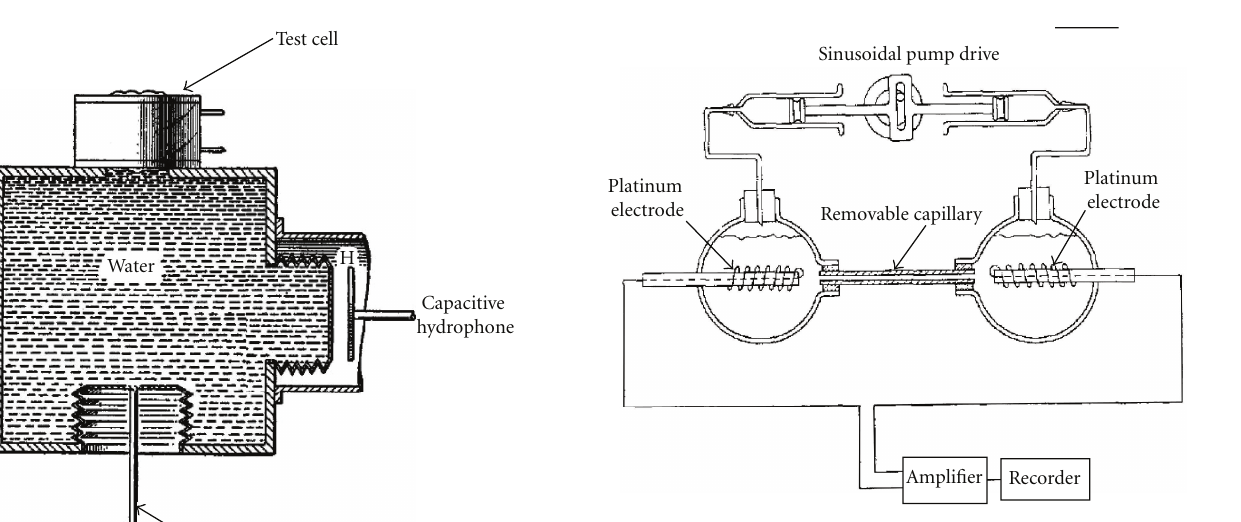
Figure 4: Experimental setup used by Groves and Sears (modified from [88]).